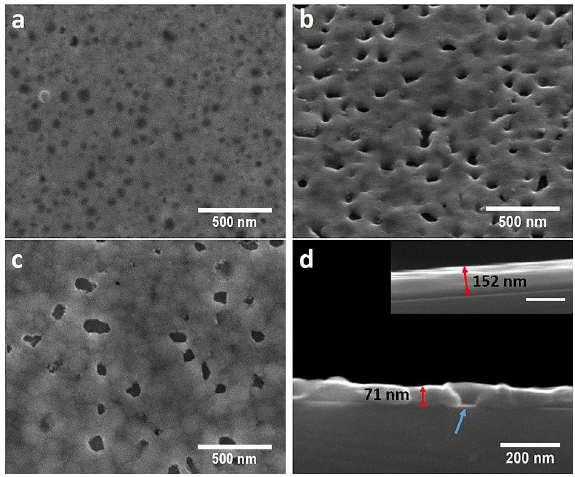
Figure 3: SEM image of a 200 nm sputtered silver film treated with nitrogen plasma (g12-p200) for (a) 10 min, (b) 30 min and (c) 60 min at 50000× magnification. (d) Cross-sectional SEM image of 200 nm sput- tered silver film treated with nitrogen plasma (g12-p200) for 30 min showing the actual thickness of the prepared silver film after nitrogen plasma treatment compared to the as-sputtered silver film seen in the inset (scale bar is 200